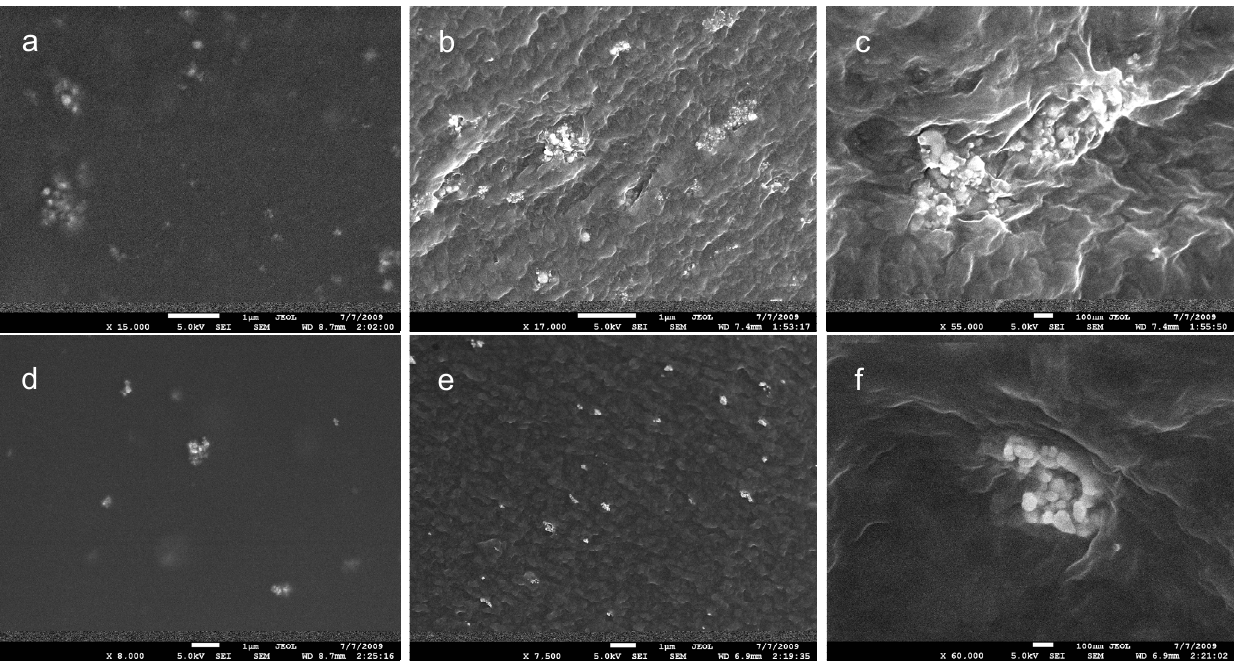
Figure 3. Scanning electron microscopy images of surface ( a and d ) and cross-sectional areas ( b,c and e,f ) of typical CH-Ag and CH-TiO composite materials, respectively. 2 Images c and f show an enlarged view of typical nanoparticle aggregates in the composite materials. All films were prepared using chitosan batch